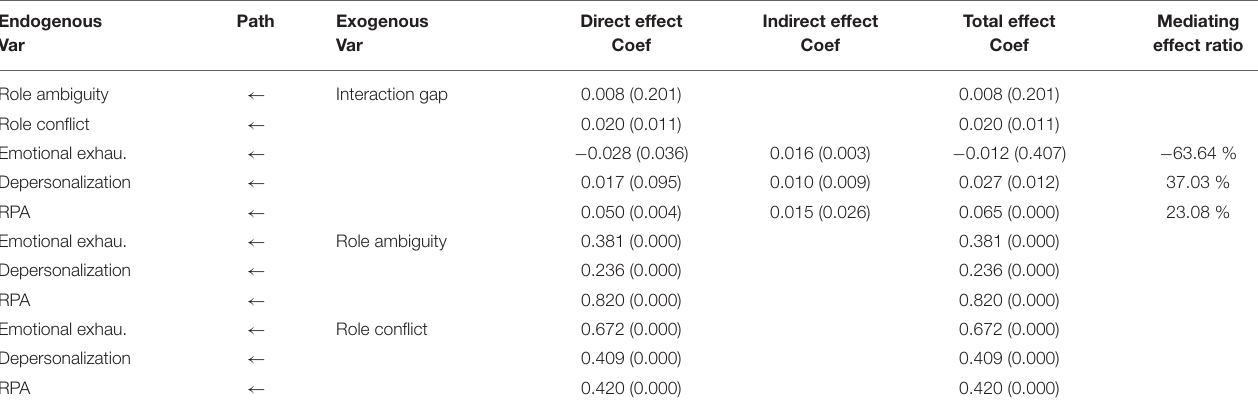
TABLE 5 | Standardized direct, indirect, and total effect and mediating effect ratio for the sample of front-line social workers. Endogenous Var